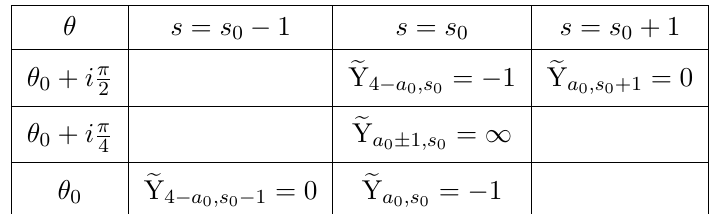
Table 1 . Singular points fixed through the recursion relations (2.15) by the occurrence of a singular point e Y ( θ ) = − 1 with Im θ a 0 ,s 0 0 affected by the singular point.